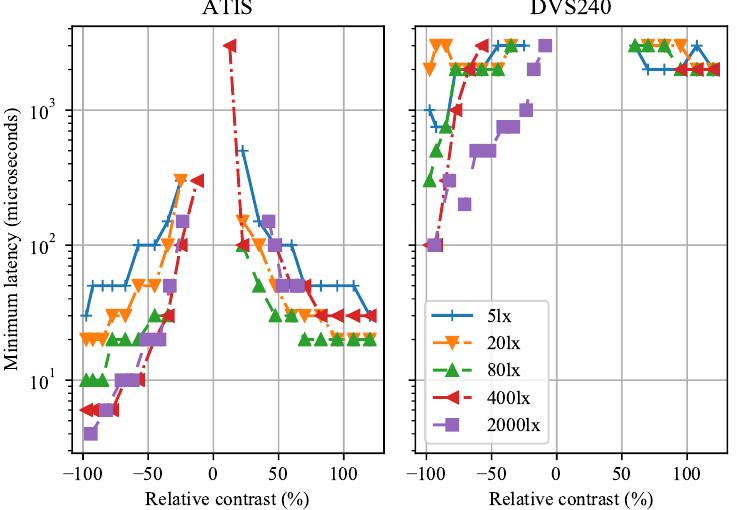
Figure 4. The minimum pixel latency of the ATIS and DVS240 event cameras depends on the contrast and illuminance (see the